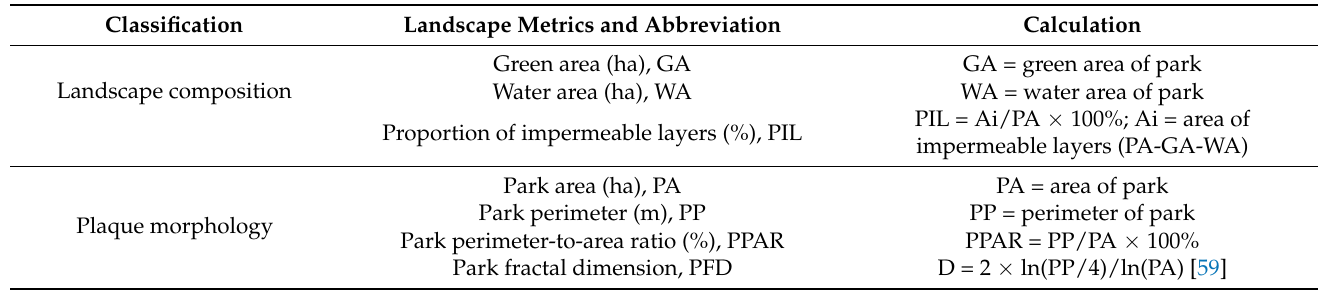
Table 2. Landscape Metrics of Shanghai’s Park and calculation